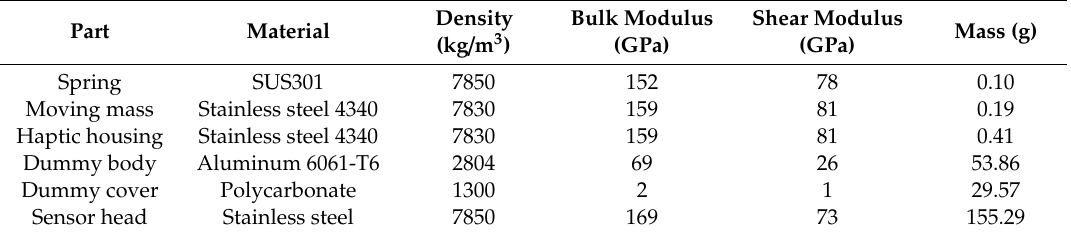
Table 3. Elastic and physical properties of the specimens used in the drop impact model.